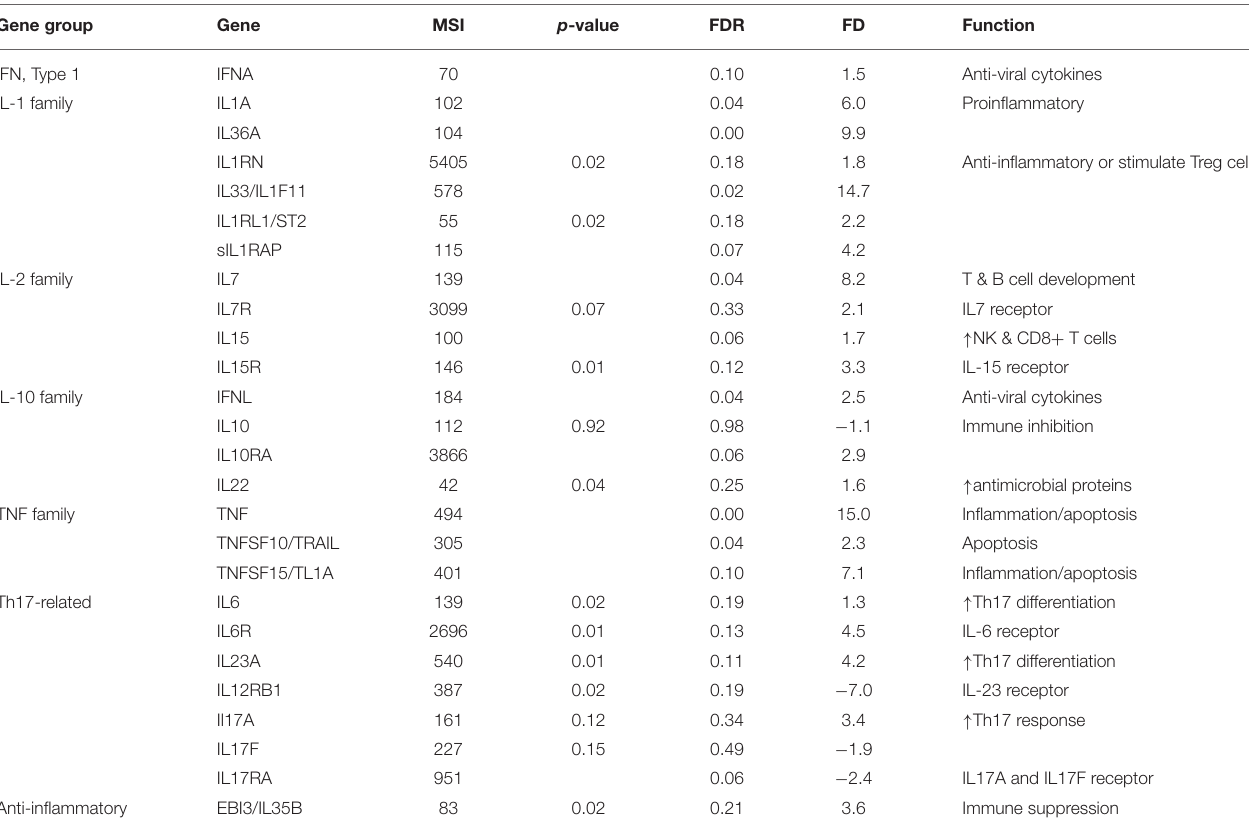
TABLE 4 | Mean expression levels (microarray signal intensity, MSI), false discovery rates (FDR) and fold differences ( + and –values as up- and down-regulated in carriers compared to non-carriers, respectively) of cytokines and the receptors differentially expressed between the nasopharynx epithelia of carriers and non-carriers. Gene